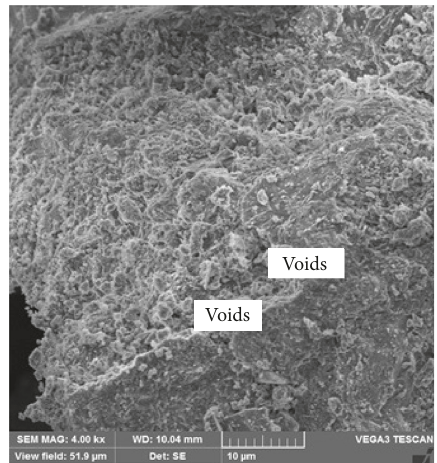
Figure 13: Microstructure of 15%